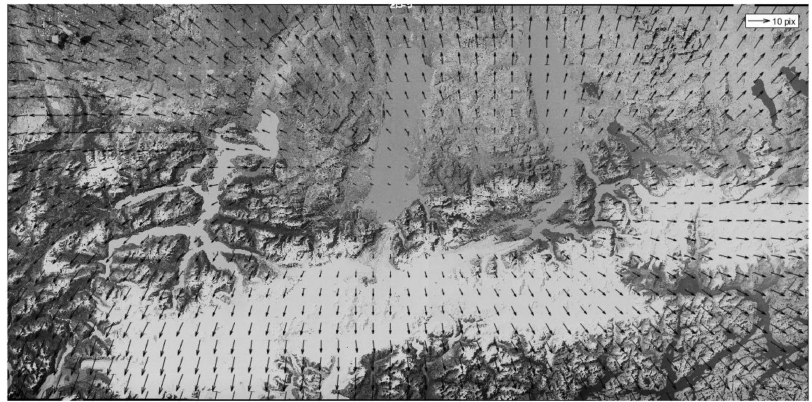
Figure 3. Distortion pattern superimposed over the left Hexagon